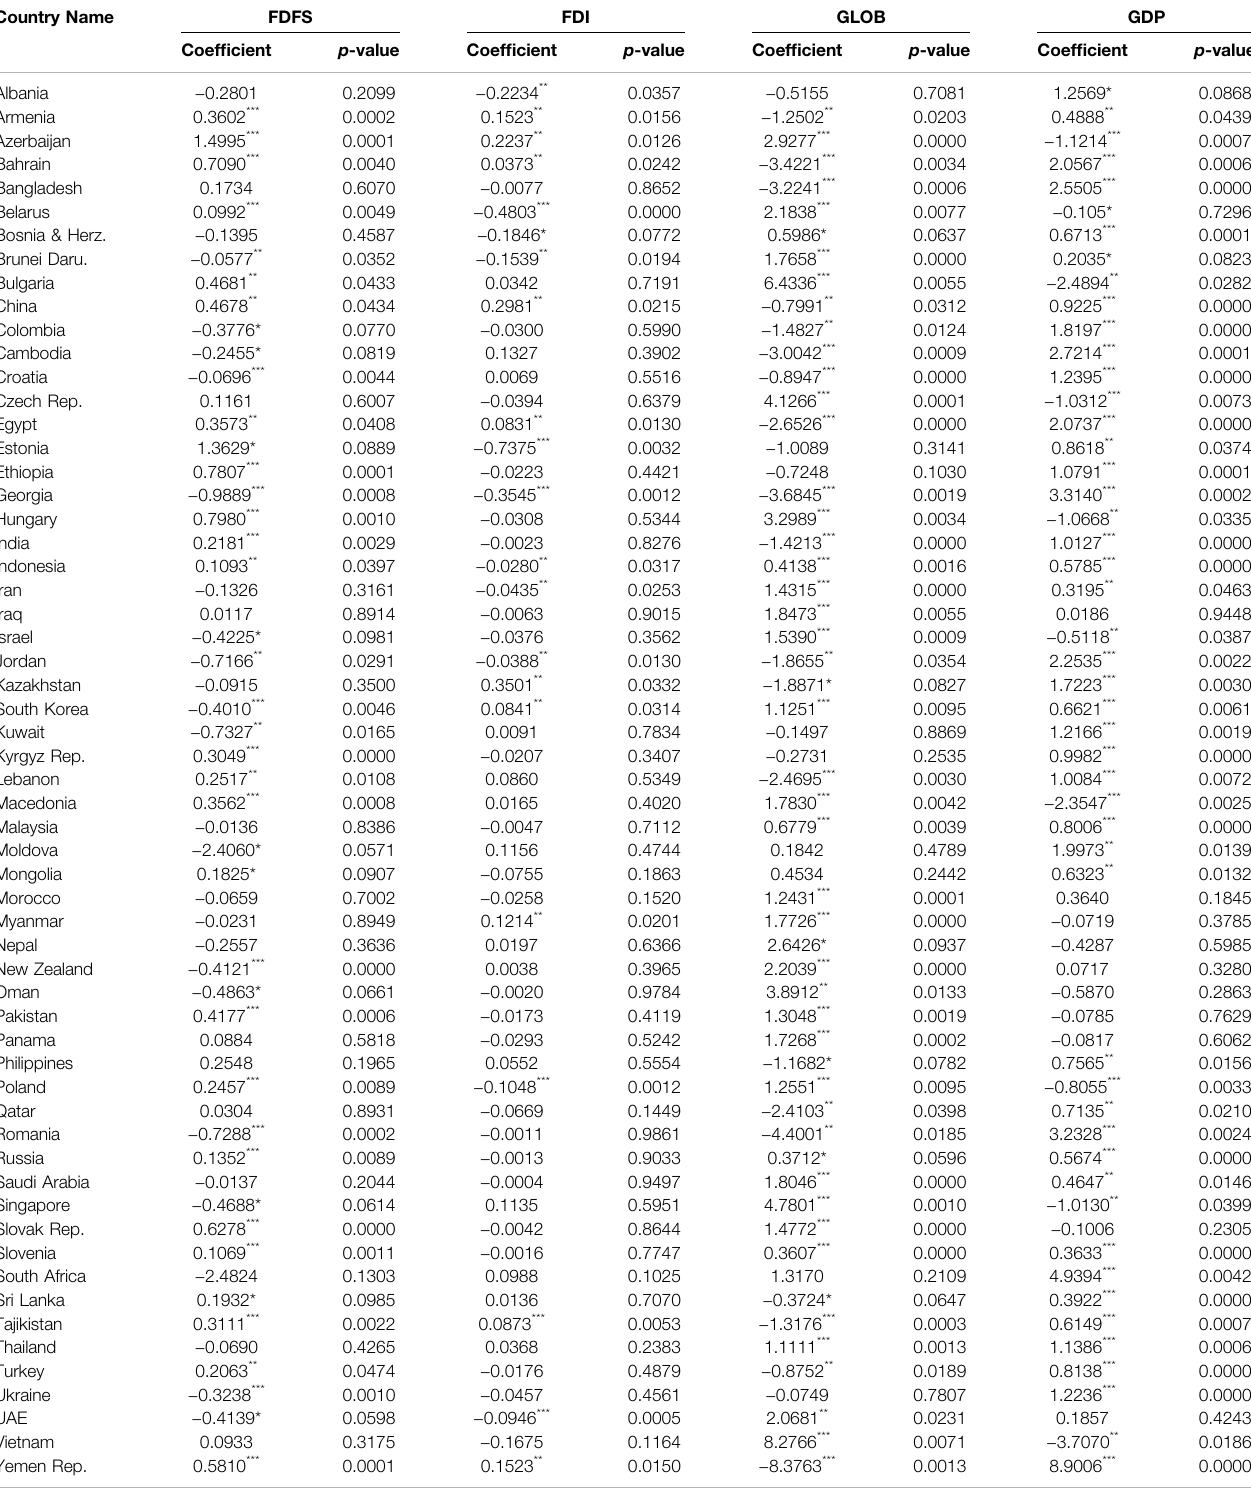
TABLE 7 | Results from DOLS